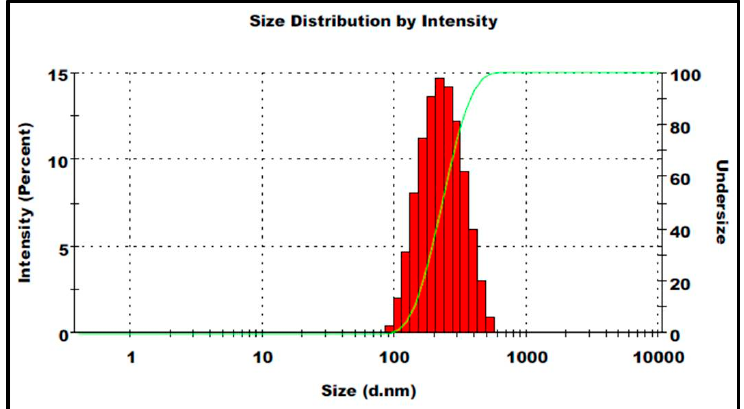
Figure 1. Histogram showing particles size and size distribution of η Cur.